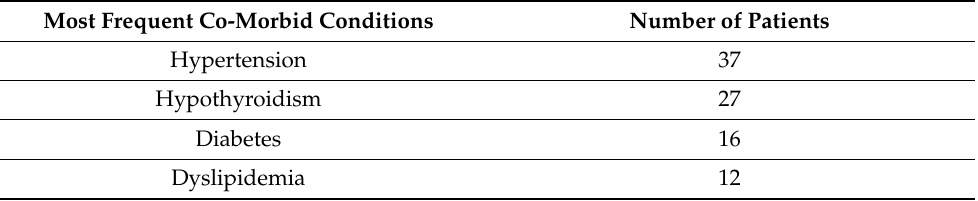
Table 3. The number of patients with the most frequently observed co-morbidities.